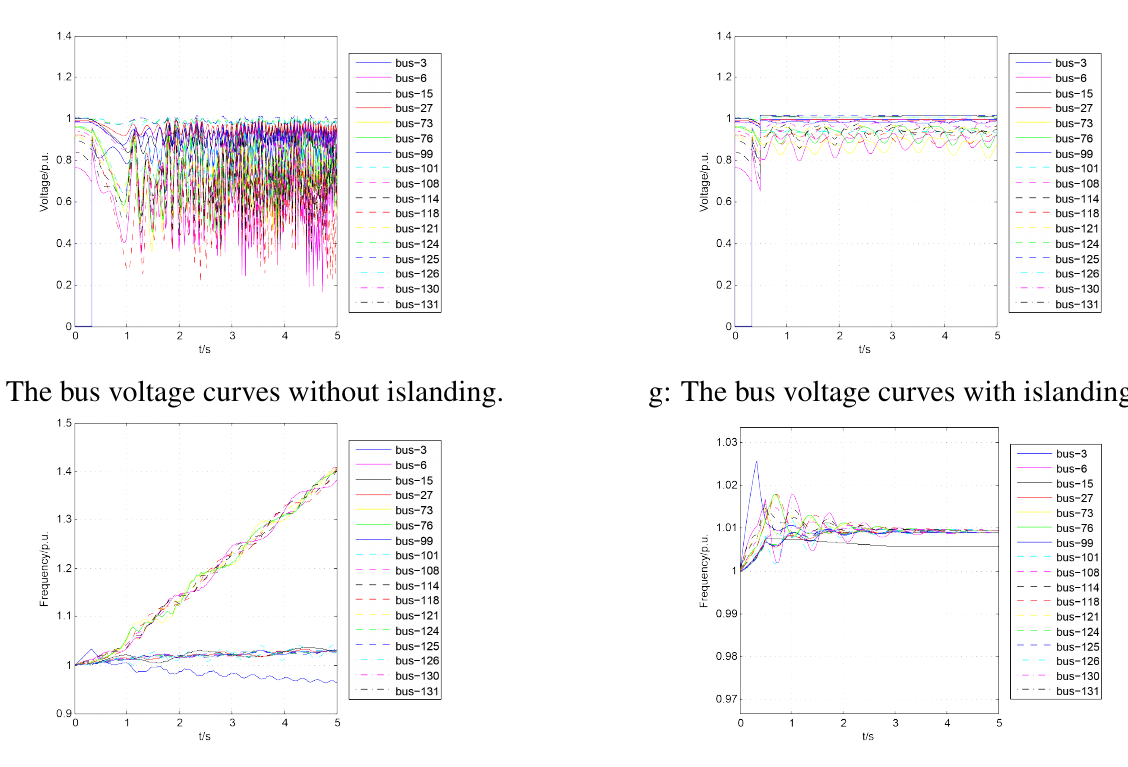
Figure 19. Comparisons with and without the islanding on IEEE the 162-bus